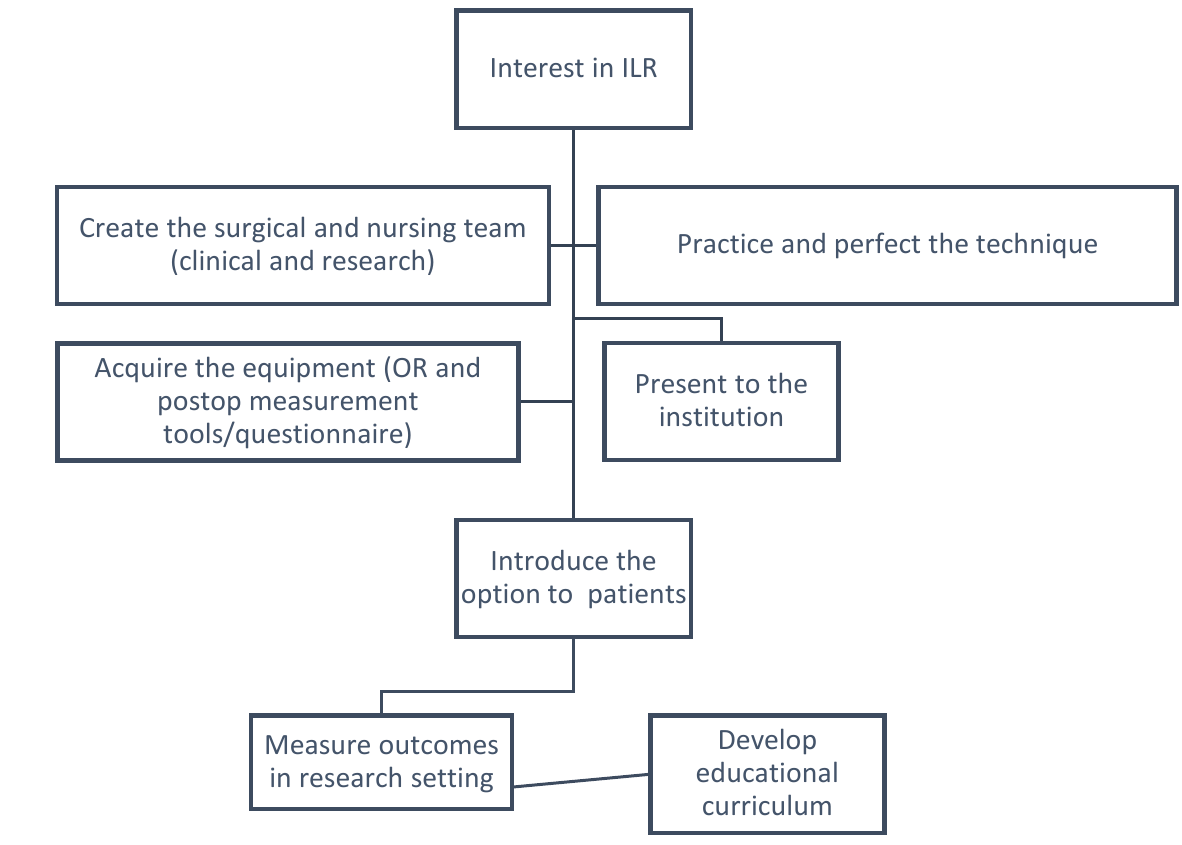
Figure 6. Summary of possible steps in elaborating an ILR